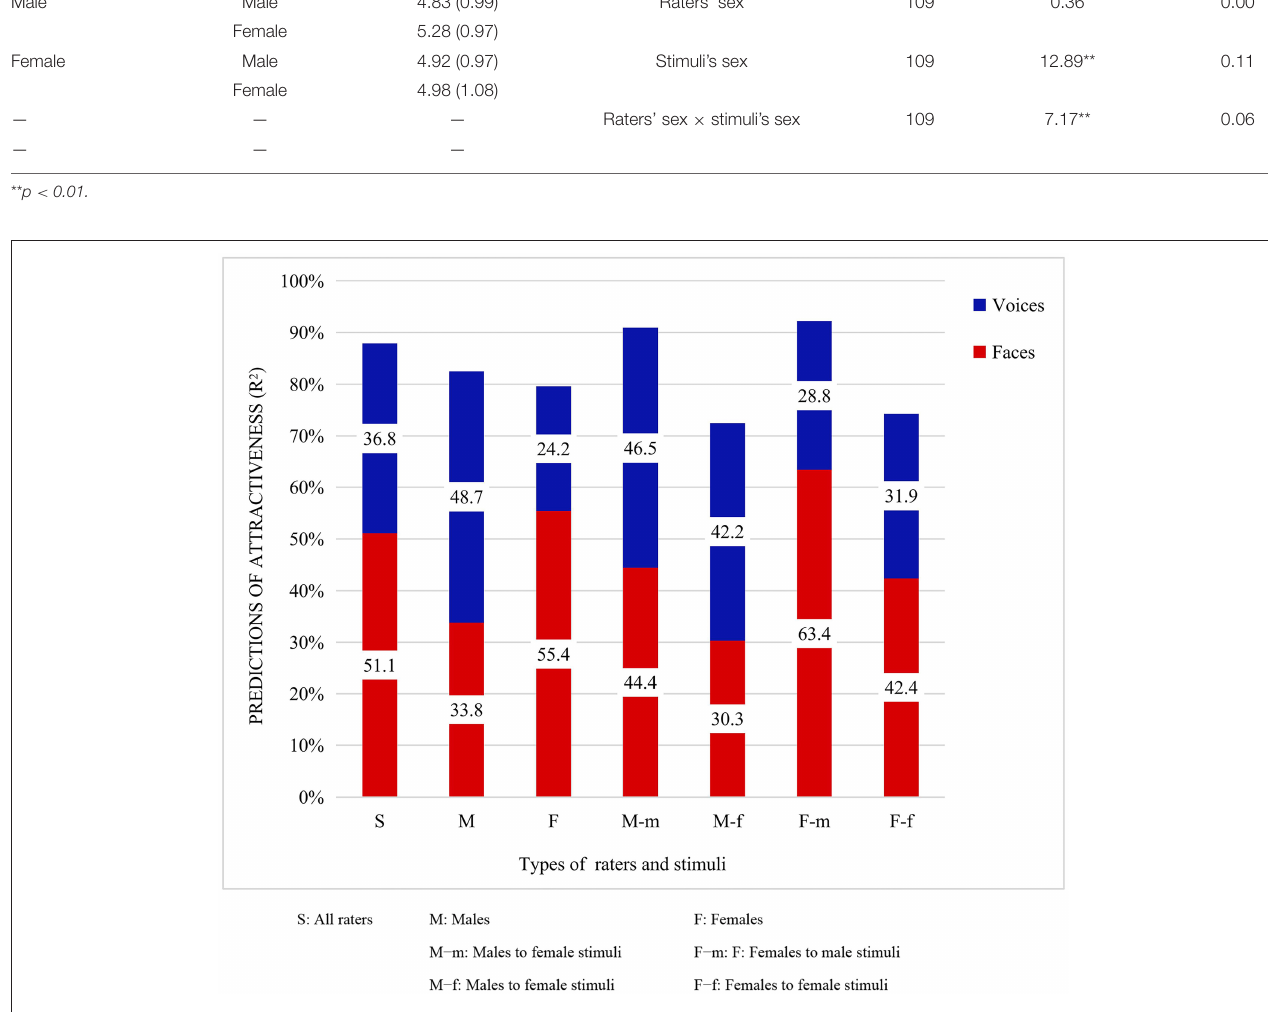
harmonious than non-OMS, and the faces and voices in OMS are probably biologically associated with each other because both of them come from the same